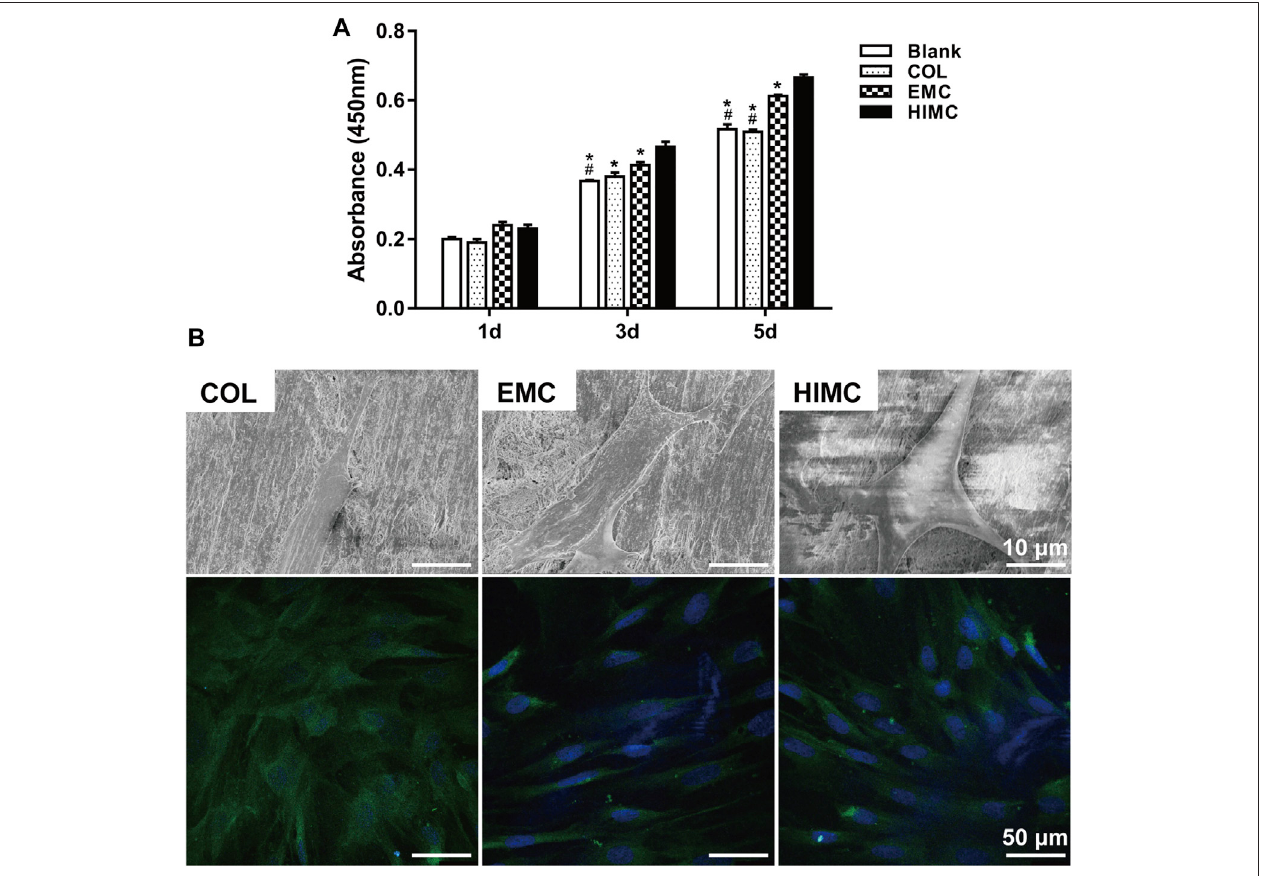
FIGURE2| GrowthandmorphologyofBMSCsculturedonthemembranes. (A) CCK-8assayresultsafter1,3,and5 daysinculture. (B) Representativeimagesof BMSC morphology after culture for 1 day, as visualized by SEM and LSCM. For LSCM images, immuno fl uorescence staining was performed for cytoskeletal proteins (green)andnuclei(blue).Dataareexpressedasmean±SD.Scalebar,10 μ minSEMand50 μ minLSCM.* p < 0.05vs.HIMCmembrane; # p <